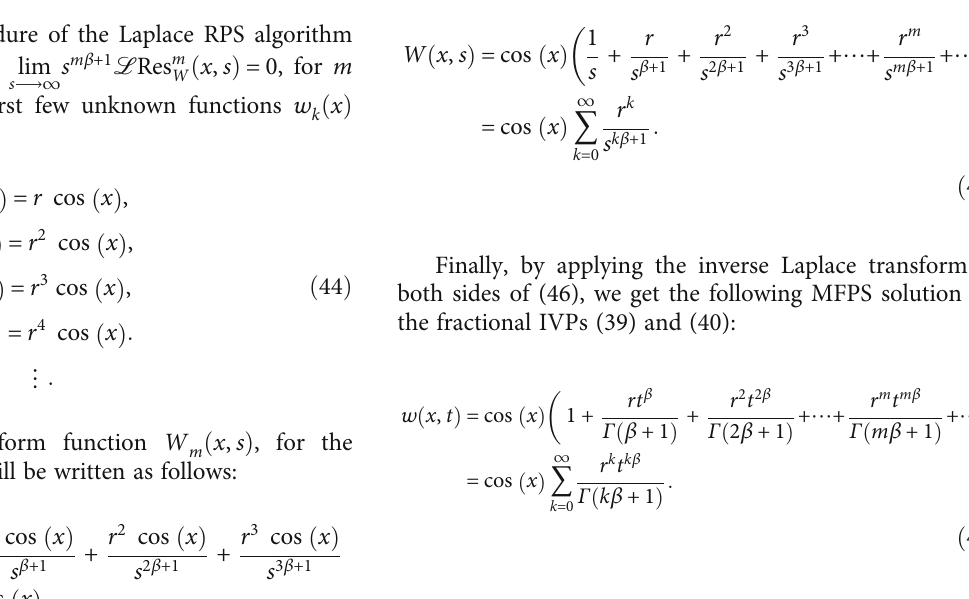
x , t Þ at various β values and x = 0 ; (b) plots w Figure 3: (a) Plots of w 5 ð